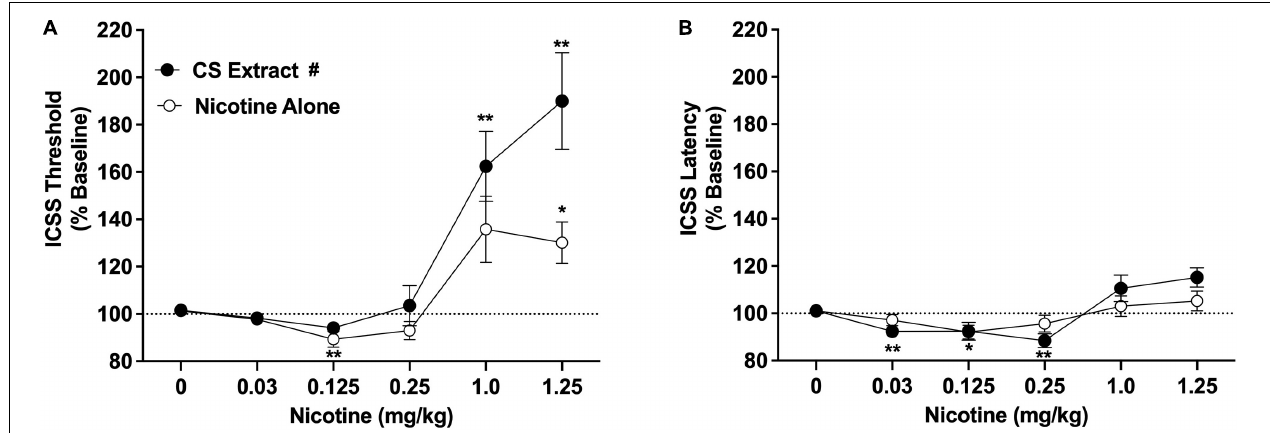
FIGURE 2 | Intracranial self-stimulation (ICSS) thresholds (A) and response latencies (B) (expressed as percent of baseline, mean ± SEM) following injection of nicotine alone or CS extract (0–1.25 mg/kg) in Experiment 2a. # Significant main effect of formulation, p < 0.05. *,** Significantly different from vehicle (0 mg/kg) for that formulation, p < 0.05 or